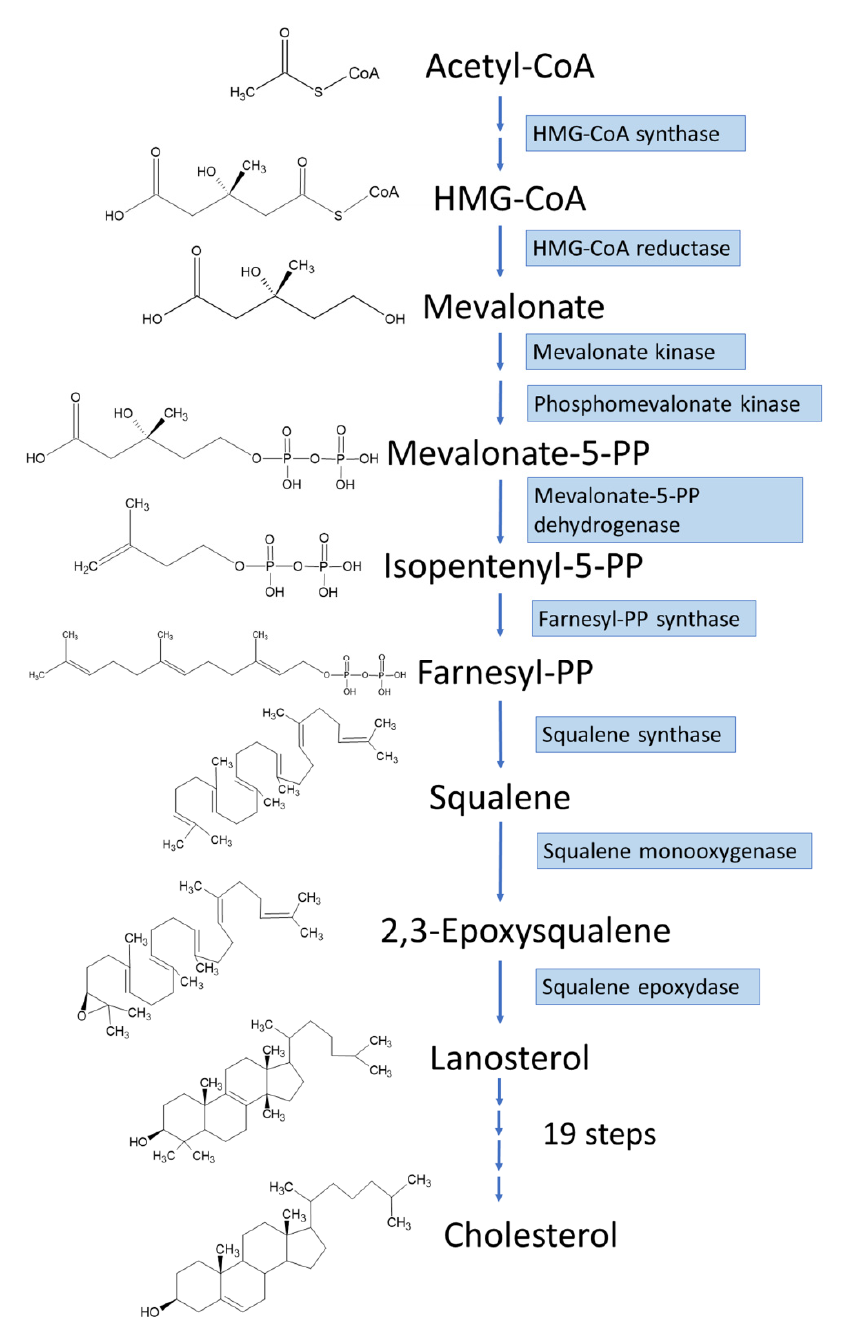
Figure 1. Cellular biosynthesis of cholesterol.